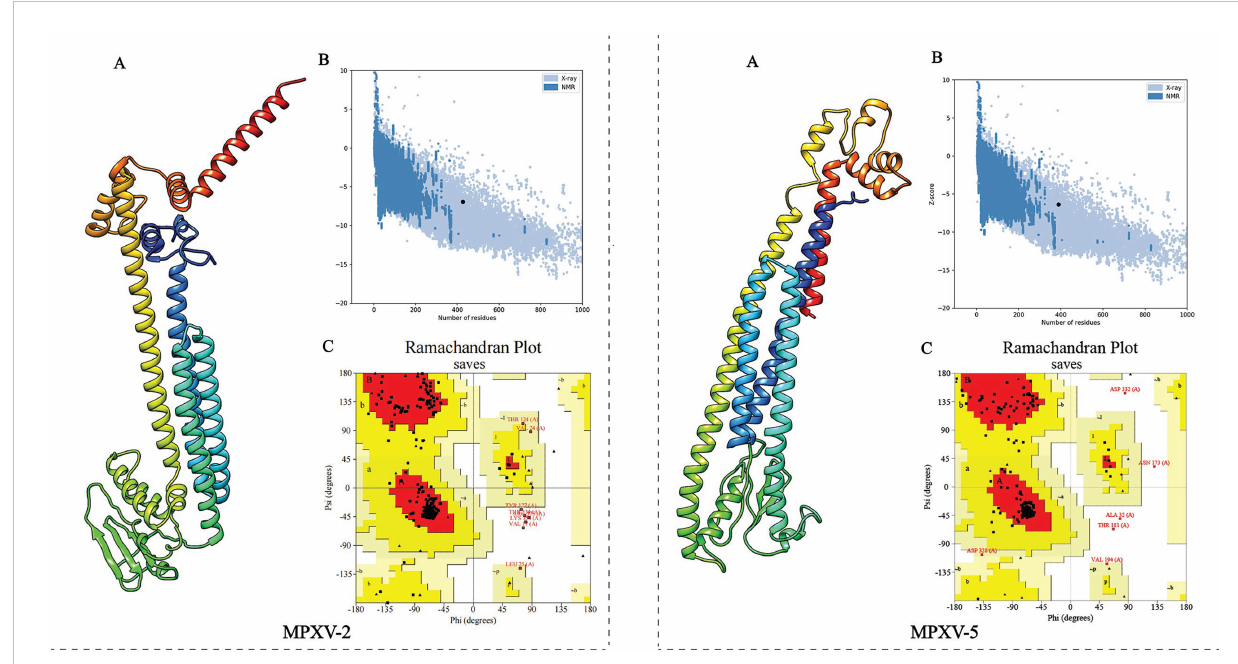
FIGURE 4 Re fi nement and quality validation of the three dimensional (3D) structure. (A) The re fi ned 3D structure. (C) Ramachandran plots of the re fi ned 3D structure generated by PROCHECK server; Red regions represent the most favored regions, dark yellow regions represent the additional allowed region, light yellow regions represent the generally allowed regions, and white regions denote the disallowed regions. (B) Z-Score plot of the re fi ned 3D structure predicted by ProSA-Web